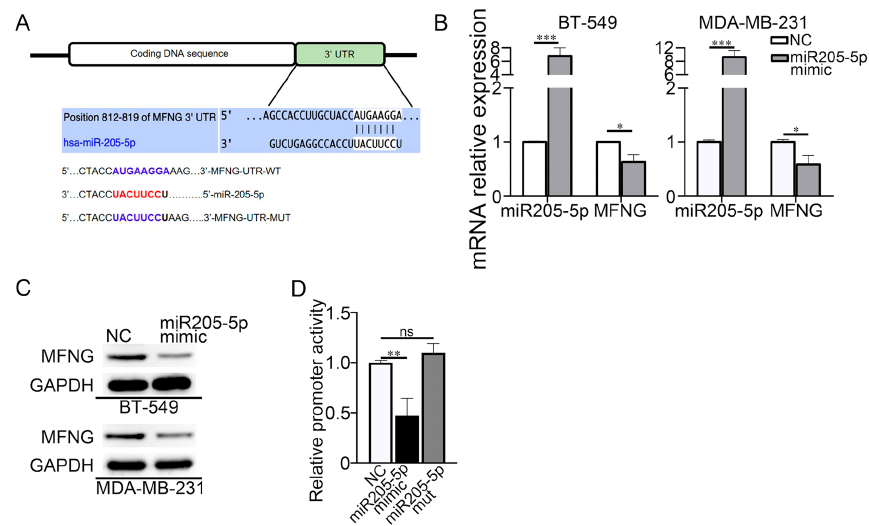
Figure 5. miR205 ‐ 5p reduced the MFNG mRNA level by directly binding to its 3 ′ UTR region and inhibited the malignancy of TNBC cells. ( A ) The predicted binding sites of miR205 ‐ 5p in the 3 ′‐ UTR of MFNG were performed using bioinformatics. ( B , C ) Overexpression of miR205 ‐ 5p mimic in TNBC cells reduced the mRNA and protein expression levels of MFNG, NC was short for negative control and GAPDH was loaded as an internal control. ( D ) Ectopic expression of miR205 ‐ 5p reduced the luciferase activity of wild ‐ type 3 ′‐ UTR of MFNG in MDA ‐ MB ‐ 231cells. Data were analyzed using a Student’s t ‐ test. All * p < 0.05, ** p < 0.01, *** p < 0.001, ns: not significant.